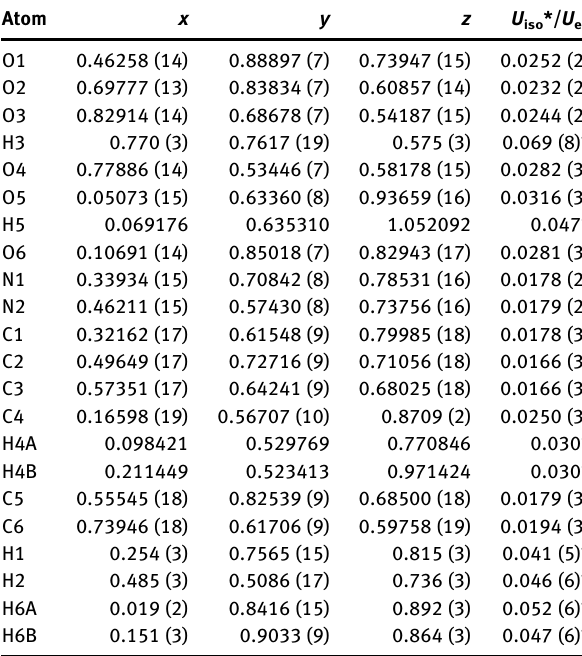
Table  : Fractional atomic coordinates and isotropic or equivalent isotropic displacement parameters (Å 